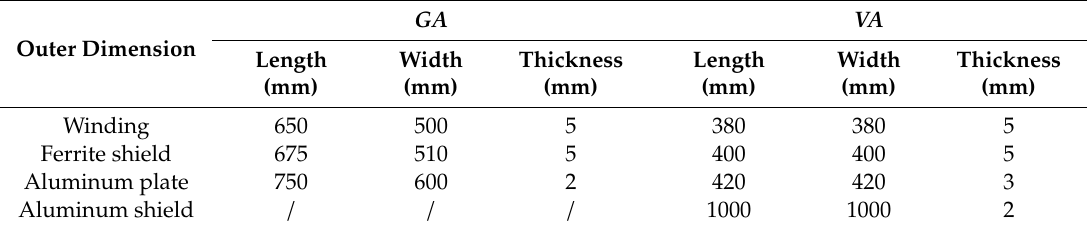
Table 1. Electro-geometrical configuration of the considered WPT